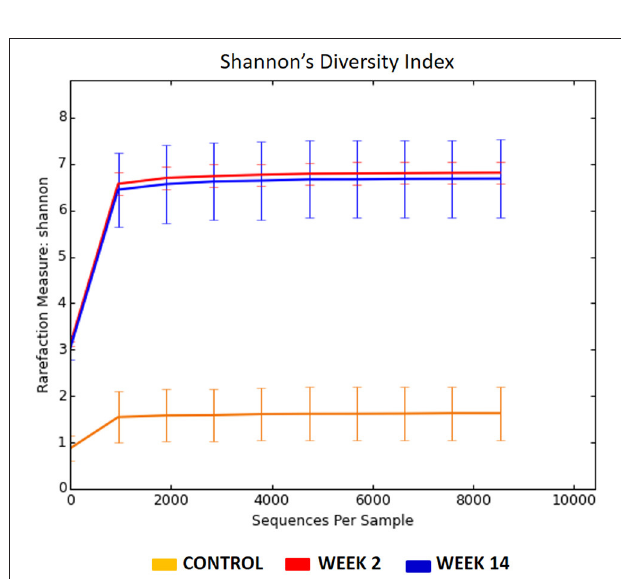
FIGURE 7 | Rarefaction curves for the 16s rRNA gene sequences from three different groups (Control = Orange, Week 2 = Red, Week 14 = Blue). The Shannon’s diversity index was significantly elevated in rabbits with acute (week 2) and chronic (week 14) sinusitis compared to controls (Control = 15.34 ± 0.07, Week 2 = 63.93 ± 0.34, Week 14 = 62.71 ± 0.34, p <